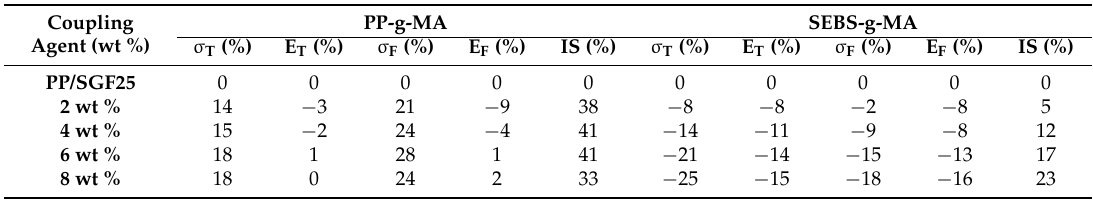
Figure 4. Chemical reaction between PP-g-MA and SGF.